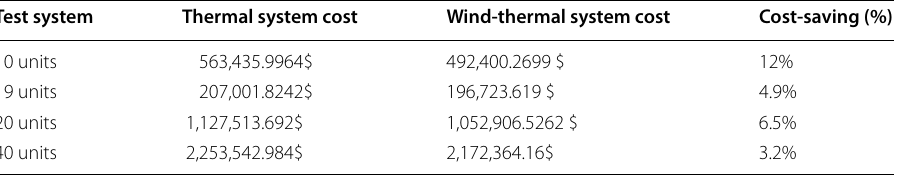
Table 7 Percentage cost-saving for 10-, 19-, 20-, and 40 units using hHHO–IGWO